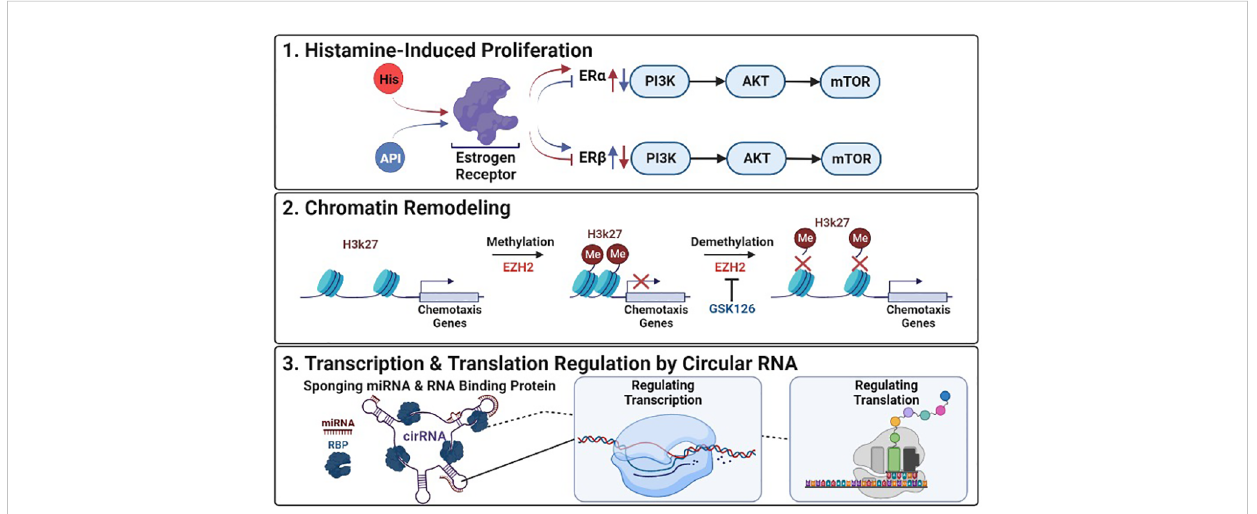
FIGURE 1 Epigenetic Deregulation in Cancer: (1) Histamine-Induced Proliferation: Histamine (HIS) upregulates ER a and downregulates ER b promoting proliferation and tumor development, Apigenin (API) inhibits ER a and upregulates ER b suppressing histamines effects. (2) Chromatin Remodeling: GSK126 inhibits EZH2 reversing transcriptional repression of genes by preventing the methylation of histone at H3K27. (3) Transcription & Translation Regulation by Circular RNA: Mechanisms by which circular RNAs (cirRNA) can alter transcription and translation of targeted genes through interactions with mircoRNAs (miRNA) and RNA binding proteins